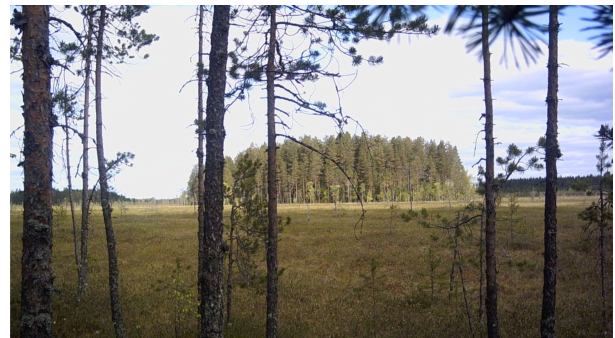
Figure 7. Pine growth at a bog site in Finland. View across a stretch of treeless bog. In front are small trees, thinning out where the peat deepens. In the back large trees form a wooded “island” where the mineral ground ascends. Photo: Inke